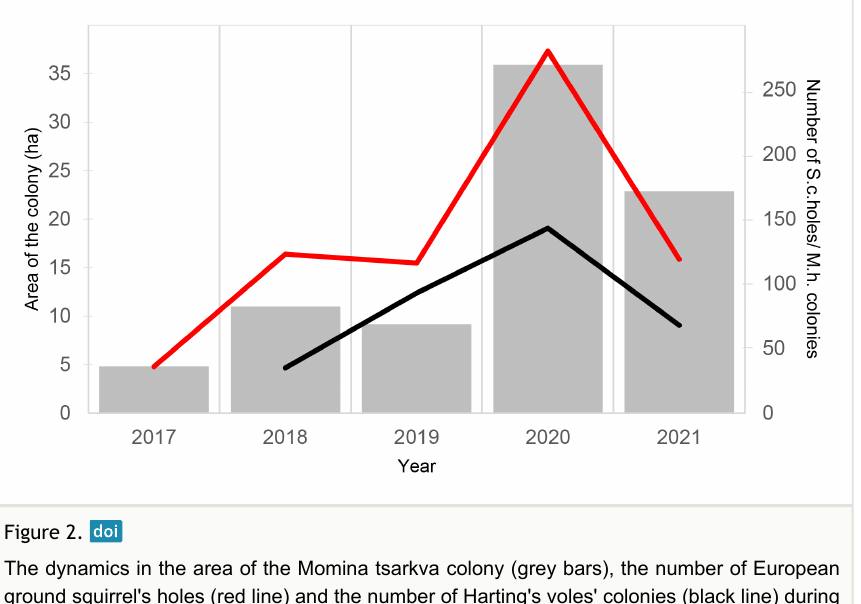
Figure 2. The dynamics in the area of the Momina tsarkva colony (grey bars), the number of European ground squirrel's holes (red line) and the number of Harting's voles' colonies (black line) during the study period (2017-2021). The GLM shows that a statistically significant relationship exists between the spatial distribution of the Harting's vole's colonies and the ground squirrel's burrow holes in 2020 (B = 0.05, t = 5.543, p < 0.000) and 2021 (B = 0.32, t = 2.565, p = 0.015). The analysis did not show significant relationship for 2018 (B = 0, t = -0.006, p = 0.996) and 2019 (B = 0.08, t = 0.517, p = 0.612).